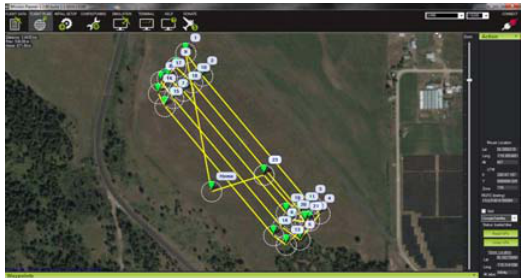
Figure 5. Mission